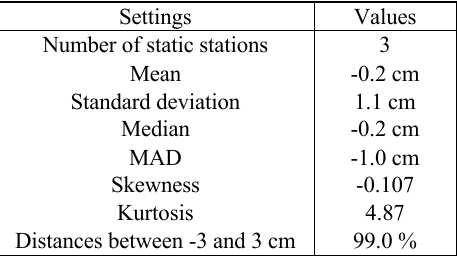
Table 10. Results of loop 2